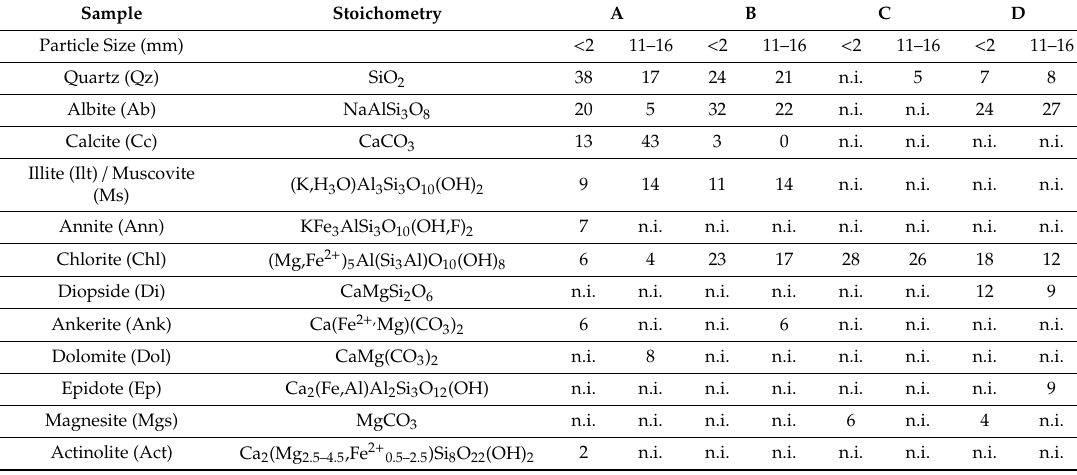
Table 2. Mineralogical composition (wt %) of the investigated samples (same as in Table 1) derived from XRD. A: quaternary gravel, B: diabase greywacke mixture, C: serpentinite, D: amphibolite breccia; terminology is according to the supplier and not according to scientific rock classification. n.i.: not identified. The relative error is in the range of